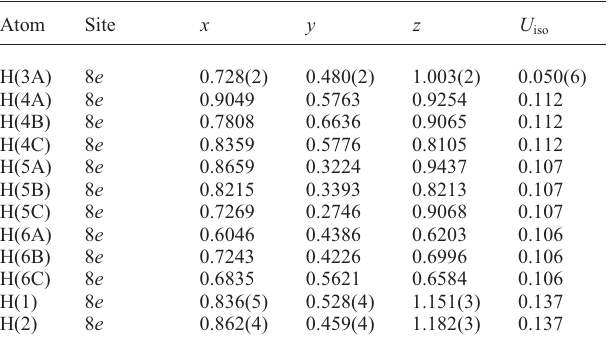
Table 2. Atomic coordinates and displacement parameters (in Å 2 )